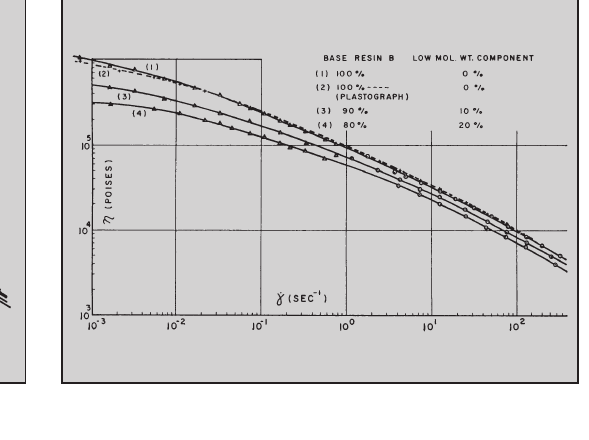
Figure 5 (left): Effect of high molecular weight component on flow curves. Figure 6 (right): Effect of low molecular weight component on flow